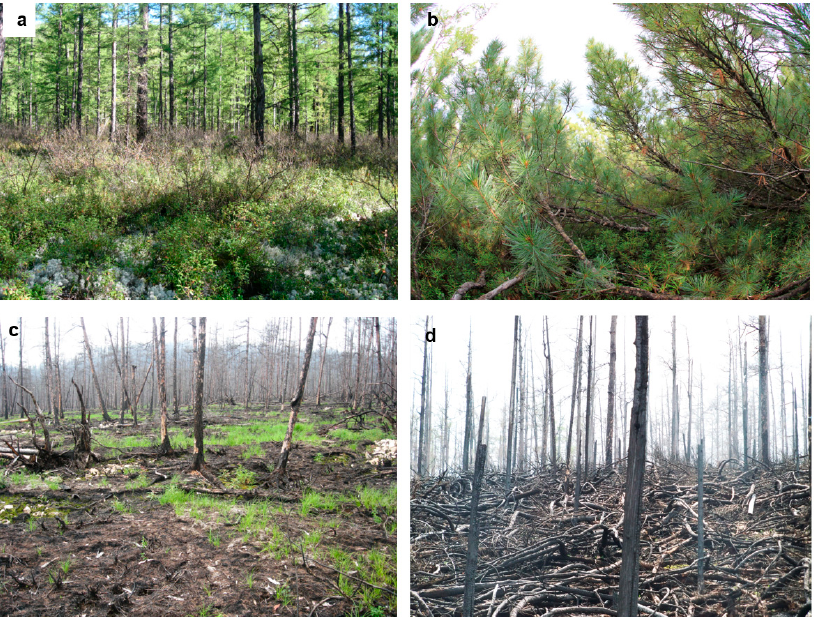
Figure 8. Photographs of two unburned stands dominated by the deciduous coniferous tree Larix gmelinii ( a ) and the evergreen coniferous shrub Pinus pumila ( b ), and two 1-year post-fire stands previously dominated by Larix gmelinii ( c , surface fire) and Pinus pumila ( d , canopy fire) in Huzhong Natural Reserve, China.